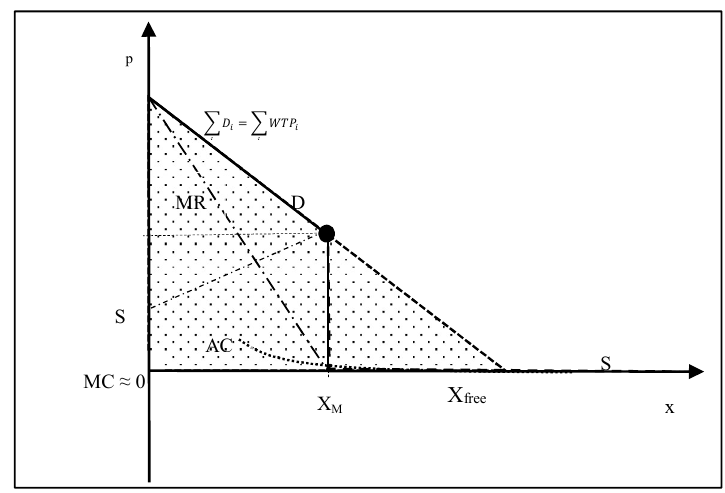
Figure 1. Pricing Schedule for online platforms. Source: Author.